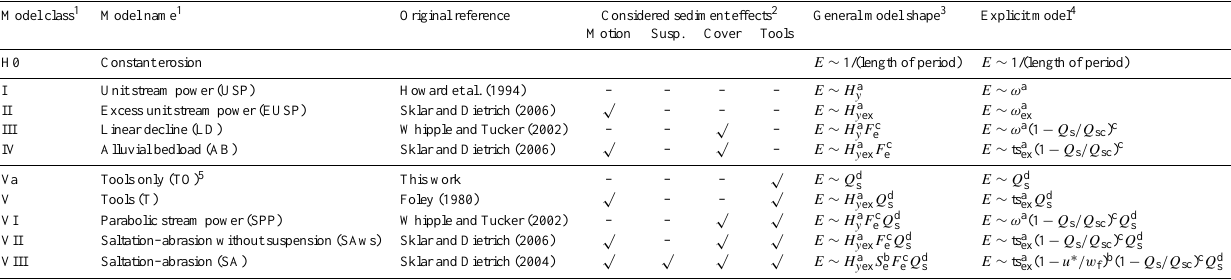
Table 2. The applied incision models. The second horizontal line subdivides models that include the tools effect from models that do not. The notation of variables in the explicit models is given in Appendix A.